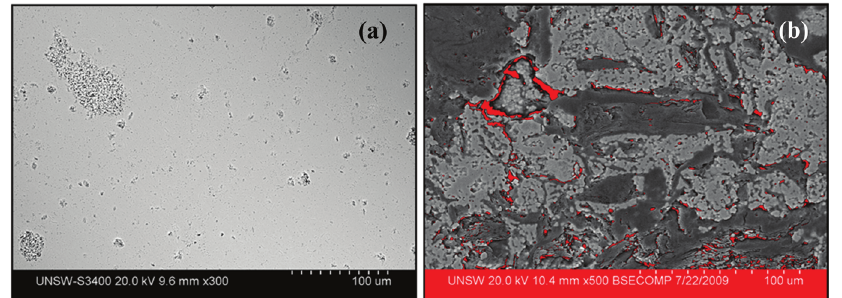
Figure 2: (a) Alumina (100%) and (b) alumina – graphite (AS1) pellet after heat treatment at 1,823 K for 30 min indicating microcracks/porous regions (marked as